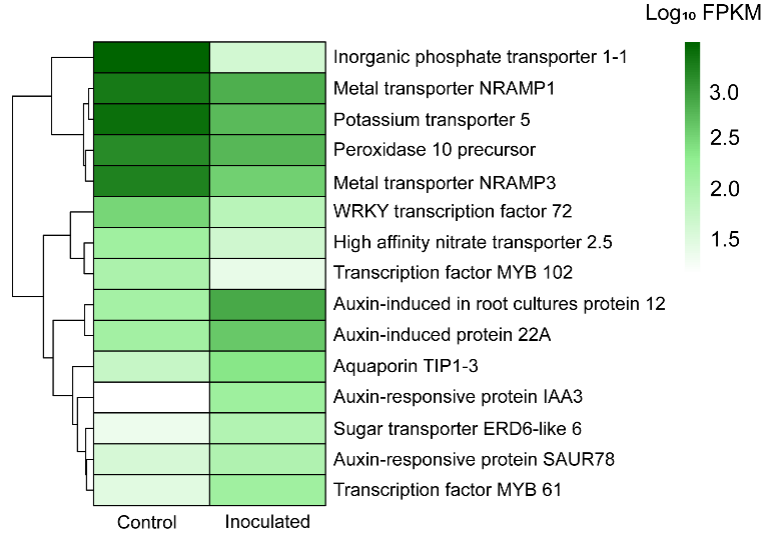
Figure 6. Heat map showing differential expression of the most important up/downregulated genes between control (without microbial inoculation) and inoculated treatment (with fungal inoculation) conditions in Eucalyptus globulus roots transcriptome.